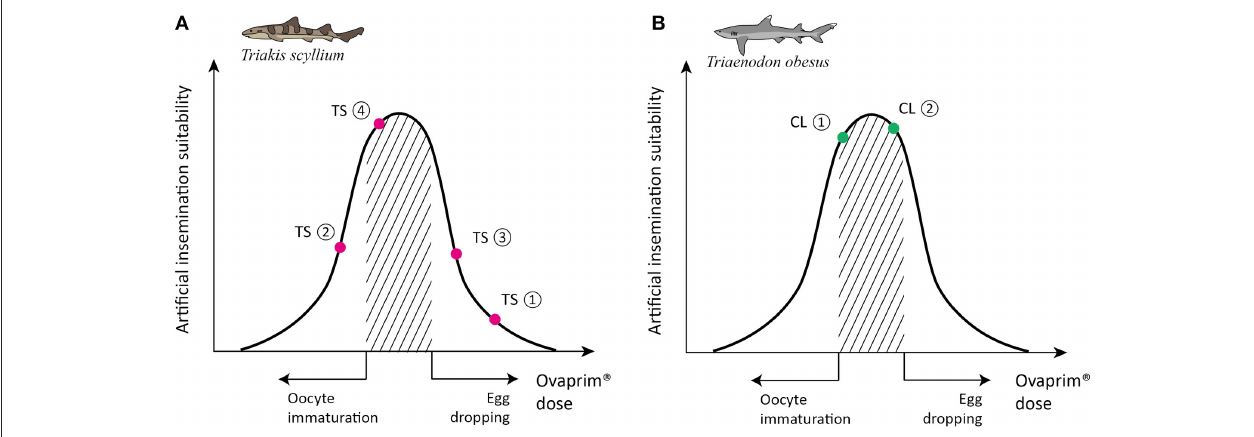
FIGURE 5 | Schematic graph of dose optimization in Triakis scyllium and Triaenodon obesus . A conceptual graph showing the correlation between biological phenomena (x-axis) and artificial insemination suitability (y-axis) that change depending on the total dose of Ovaprim ® administered. The shaded area denotes mature oocytes after follicle growth but prior to egg dropping, which is the targeted area for females in this study. (A) Ovaprim ® experimental doses for female T. scyllium . TS ‹ : 0.6 mL/kg + 0.6 mL/kg, 6h time gap; TS › : 0.2 mL/kg + 0.4 mL/kg, 12h time gap; TS fi : 0.2 mL/kg + 0.6 mL/kg, 24h time gap; TS fl : 0.2 mL/kg + 0.5